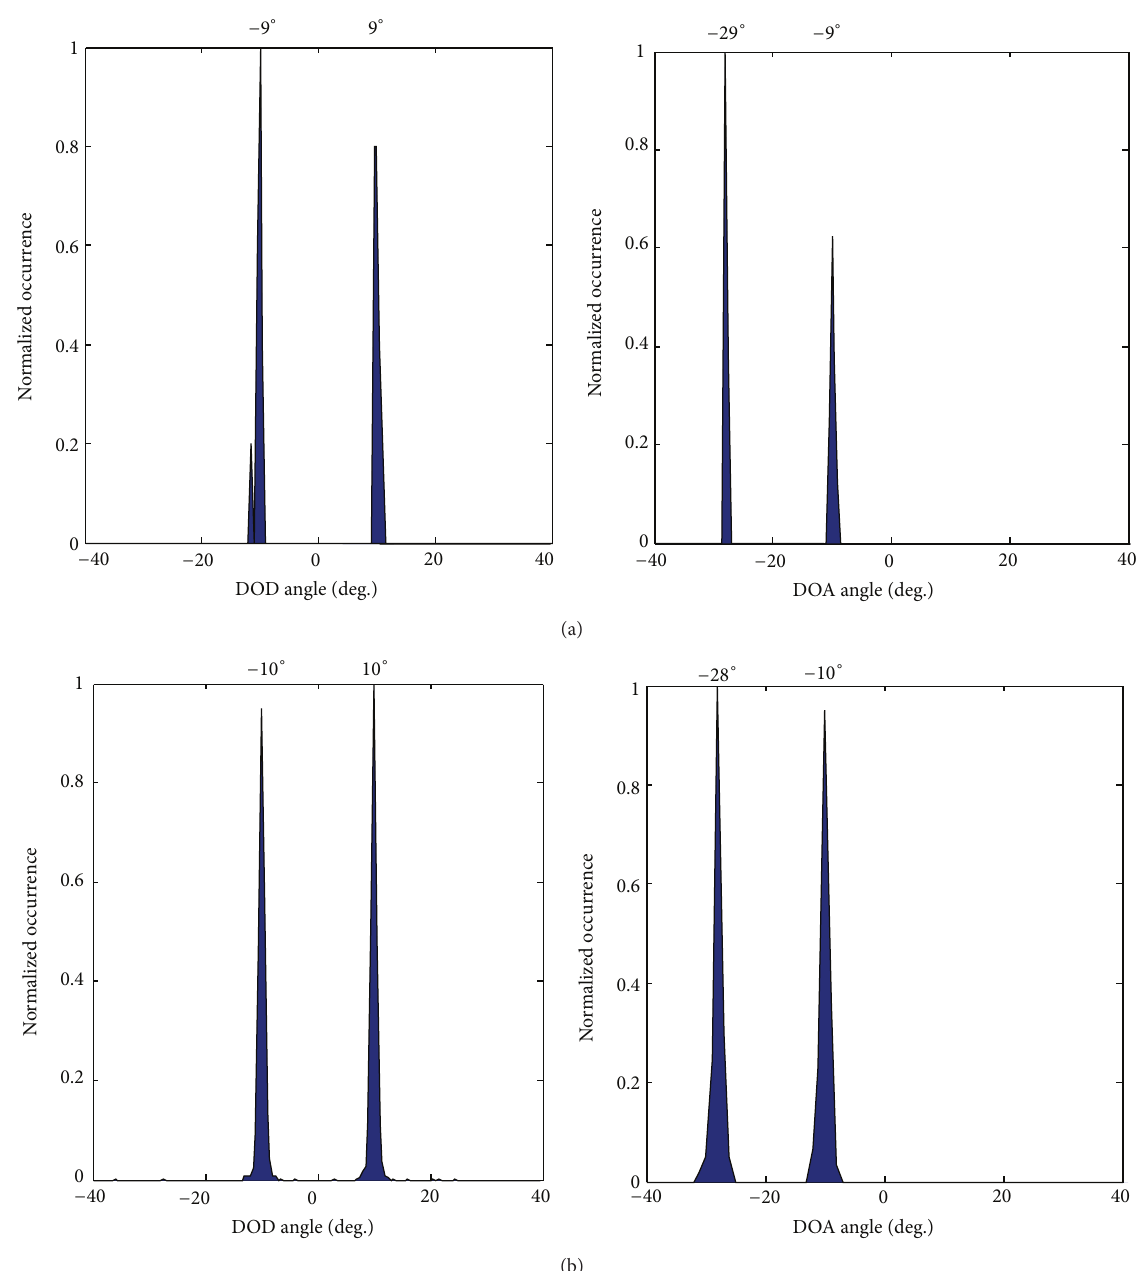
Figure 11: Angle histograms of estimated DODs and DOAs in detecting fixed point targets using a signal bandwidth of (a) 50 and (b) 1000